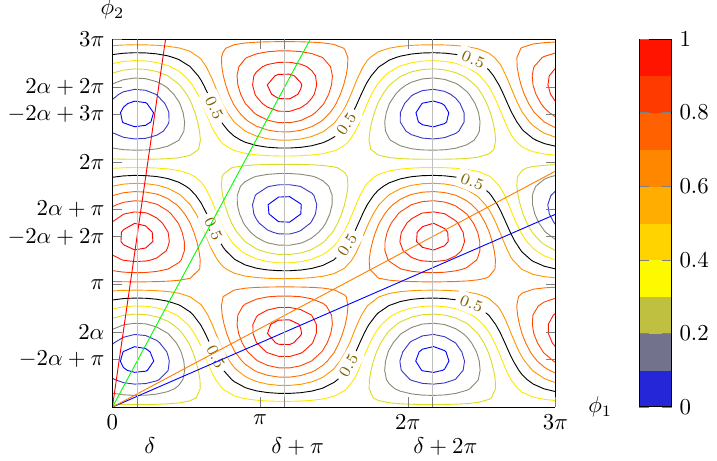
Figure 17. The pair of phase shifts as a function of frequency are lines (in different colours for each solution, refer to the legend of Figure 18) passing by the origin and the chosen peak, in the plane ( φ 1 , φ 2 ) . For comparison, the contour plots for α = 55 ◦ and δ = 30 ◦ are included. Note that those lines in general do not pass through other maxima.